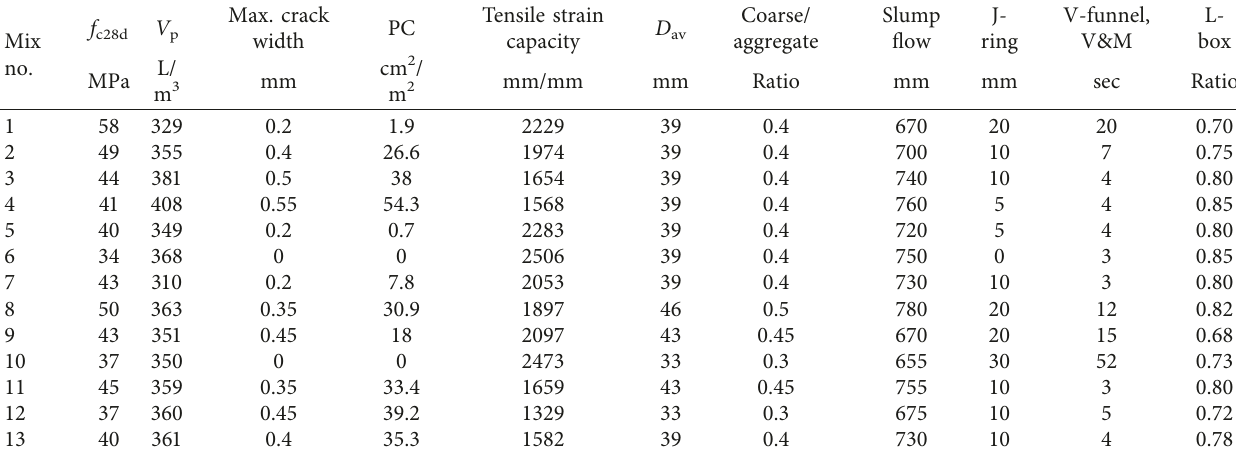
Table 3: Test results.